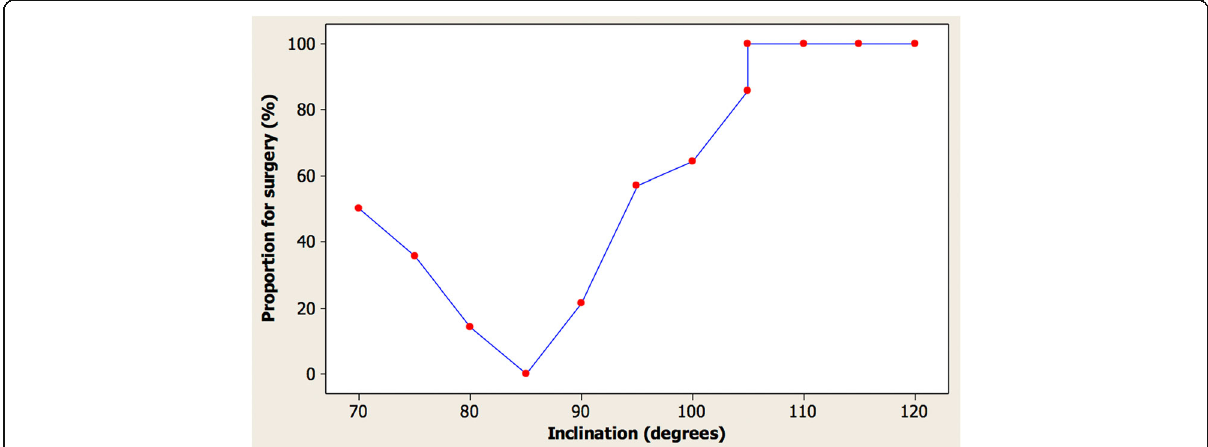
Fig. 6 Proportion of clinicians suggesting a desire for treatment vs. inclination in female